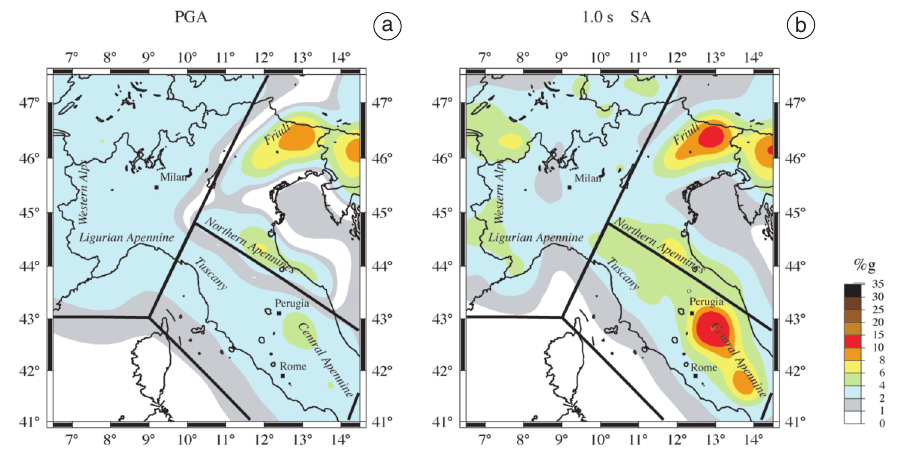
Fig. 6a,b. Parameter 95% confidence band maps in Northern and Central Italy for attenuation relationships, a) PGA and b) 1-Hz spectral acceleration.